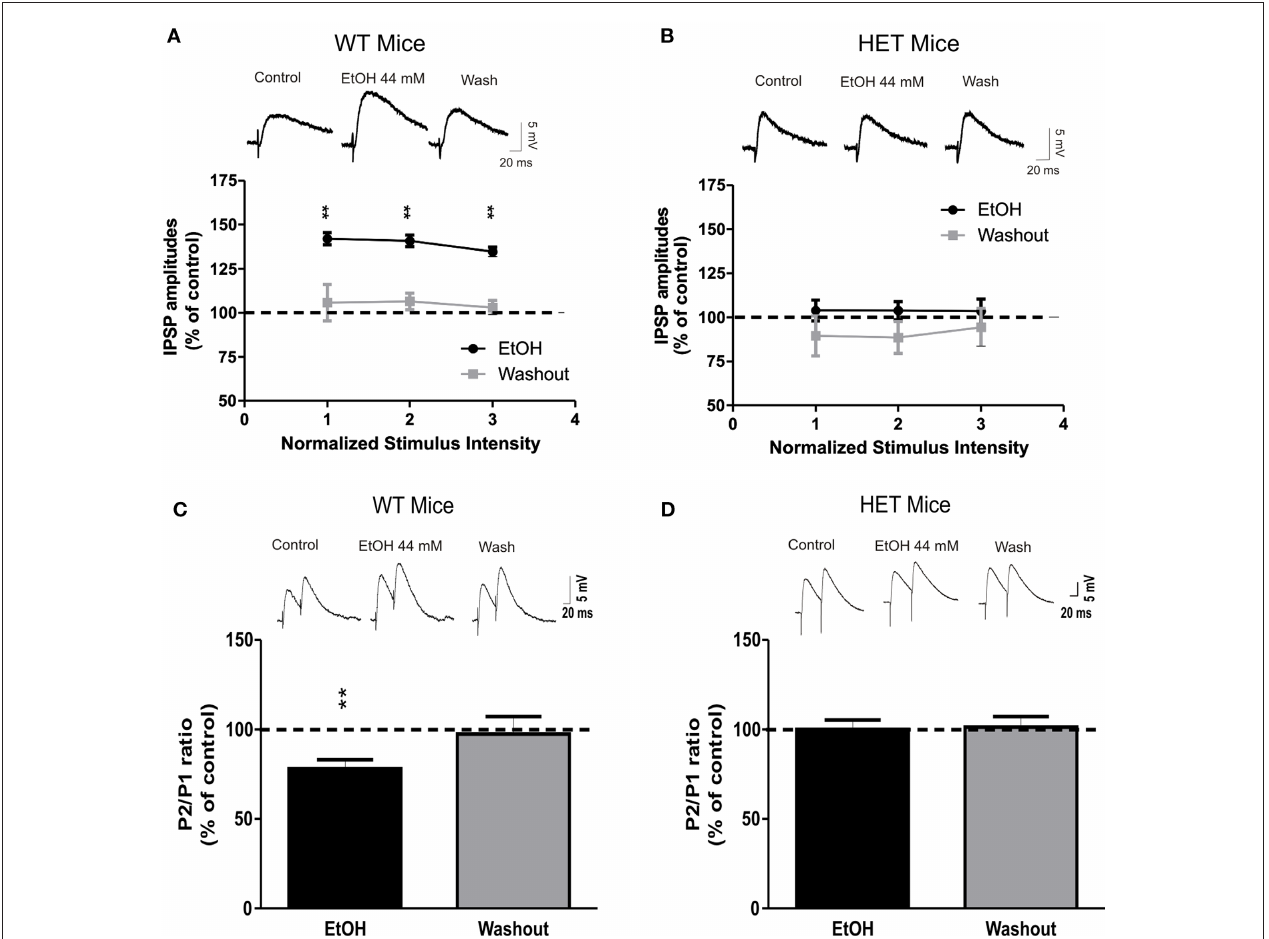
stimulus interval). Ethanol significantly decreased PPF in CeA slices from WT ( n = 10) but had no effect in HET ( n = 10) mice (D) . PPF is inversely related to transmitter release, suggesting that acute ethanol increases release of GABA in WT. Top panels of (C) and (D) : representative recordings showing effect of ethanol on PPF in CeA neurons of WT and HET mice, respectively. Statistical significance of ethanol and CRF effects calculated by Student’s t -test and set at * P < 0.05 and ** P <